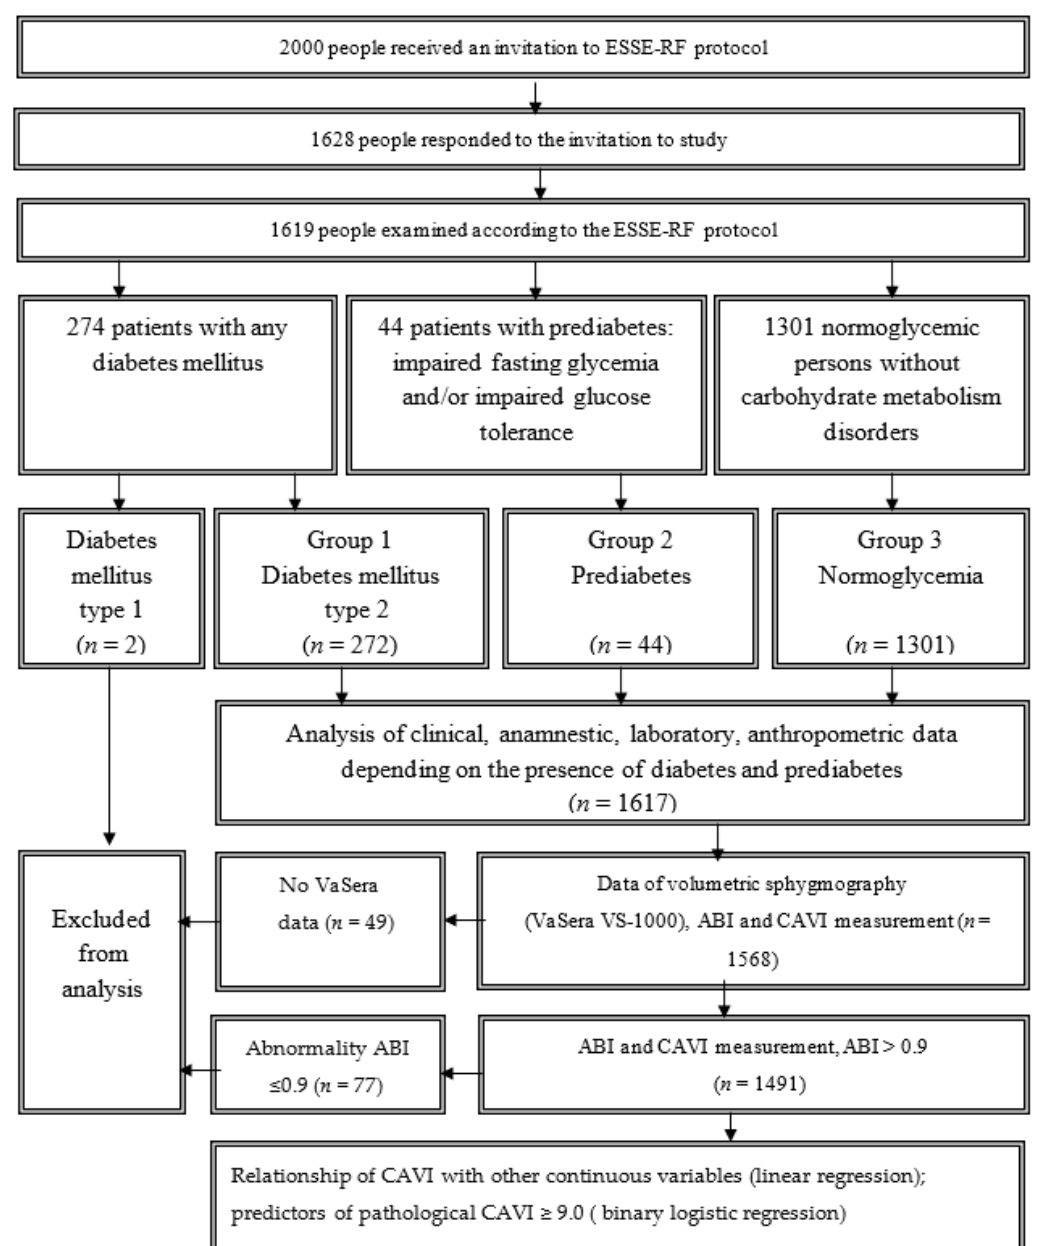
Figure 1. Flowchart of persons selection. CAVI : cardio-ankle vascular index.